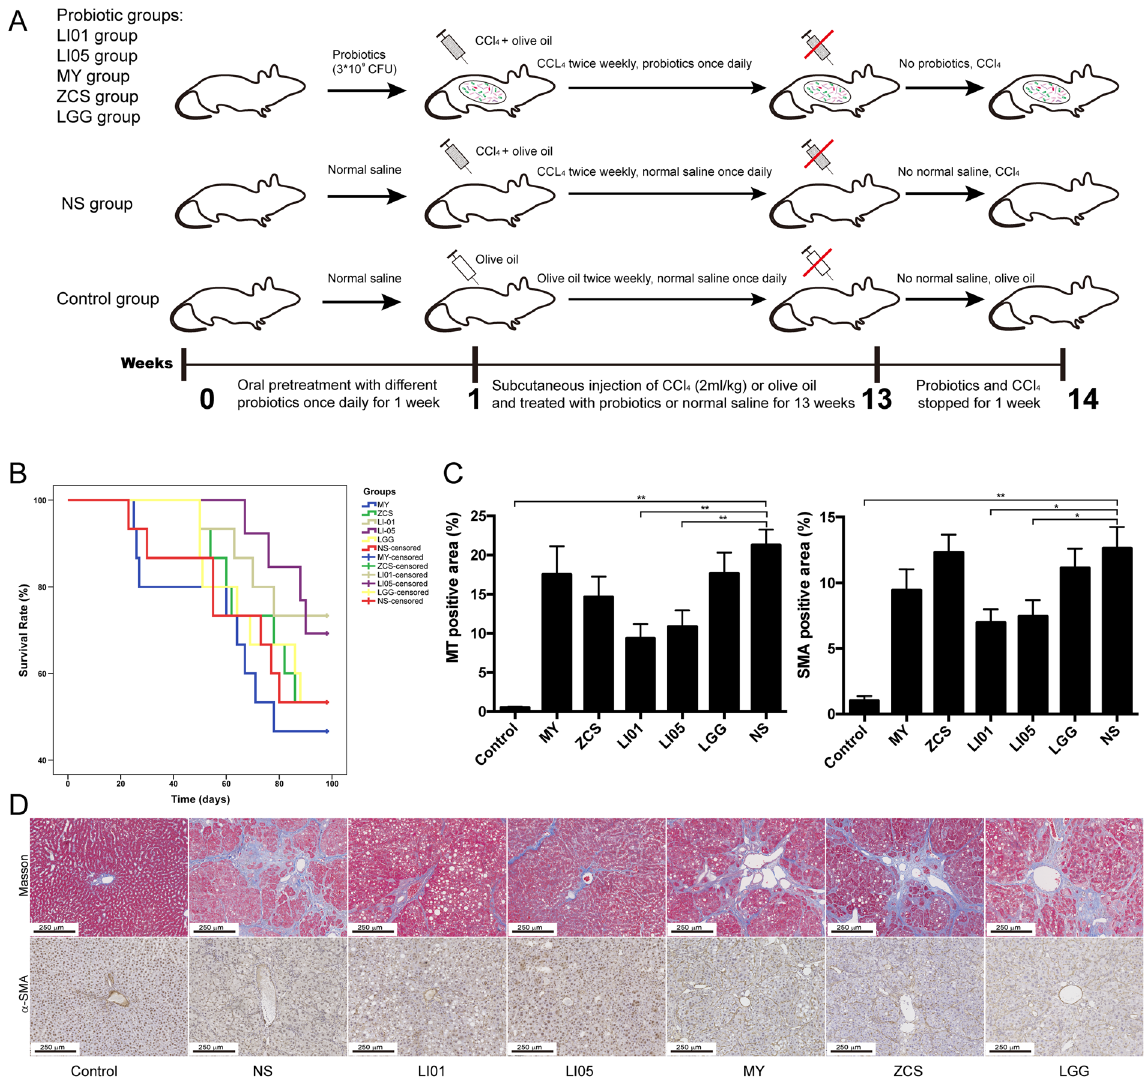
Figure 1. Treatment with L. salivarius LI01 or P. pentosaceus LI05 prolonged survival and attenuated liver fibrosis. ( A ) Experimental protocol during 14 weeks. LI01 group, cirrhotic rats treated with L. salivarius LI01; LI05 group, cirrhotic rats treated with P. pentosaceus LI05; MY group, cirrhotic rats treated with C. butyricum ; ZCS group, cirrhotic rats treated with B. licheniformis ; LGG group, cirrhotic rats treated with L. rhamnosus GG; NS group, cirrhotic rats treated with normal saline. ( B ) Survival times of the Control, NS, LI01, LI05, MY, ZCS, and LGG groups. LI01 group vs. NS group (P < 0.1), LI05 vs. NS group (P < 0.05). ( C ) Positive α -SMA or MT staining was analysed with Image-Pro Plus 6.0 software. ( D ) Representative images of liver histology and fibrillar collagen deposition assessed by MT staining. Activated HSCs evaluated by immunohistochemical staining of α -SMA from the Control, NS, LI01, LI05, MY, ZCS, and LGG groups. Scale bar: 250 μ m. All data are given as the mean ± SEM. * P < 0.05 and ** P < 0.01 vs. normal saline-treated cirrhotic rats in the NS